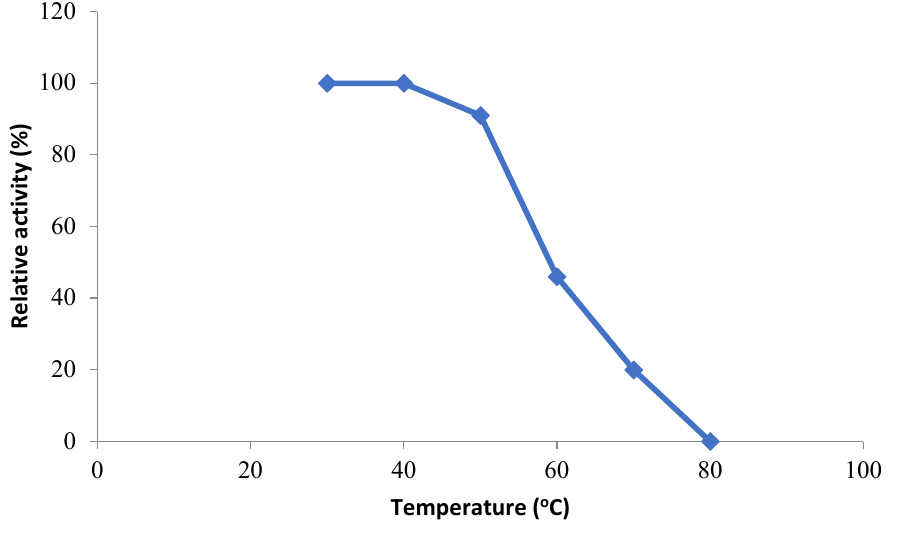
Figure 7. Thermo-stability of alkaline protease.